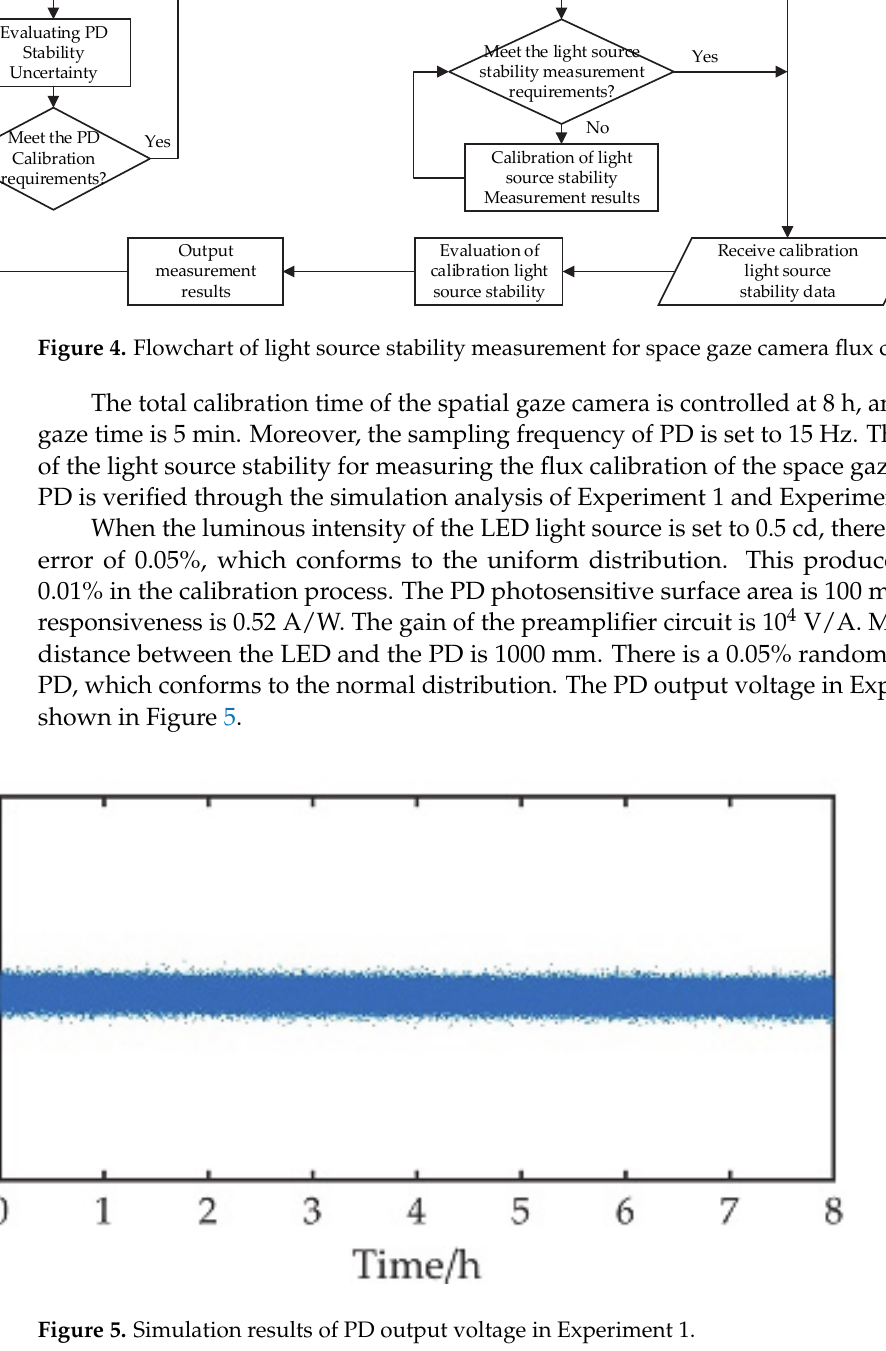
Figure 6. Simulation results of the total energy received by the PD in a single gaze time versus time in Experiment 1. The statistical analysis of the results in Figure 6 shows that the relative uncertainty of PD stability was 0.01% when the gaze time was 8 h. It is assumed that the spectral range of the space gaze camera flux calibration light source is the same as that of the LED light source. Set the luminous intensity to 1 cd, and the relative error limit is 0.05%, which conforms to the normal distribution. Moreover, the luminous intensity has a drift of 0.5% in the calibration process. The distance between the light source and the PD is 1000 mm. The output voltage of PD in Experiment 2 is shown in Figure 7.